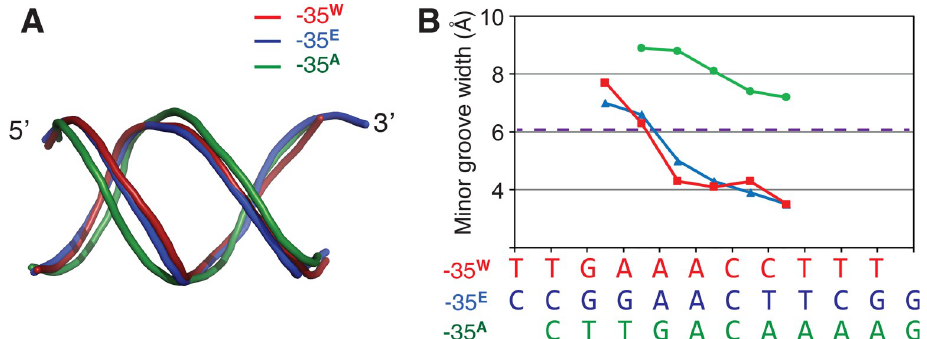
Fig 3. DNA conformation of the -35 promoter element. (A) DNA backbone geometry. -35 elements from the structures of σ W 4 /-35 W , E . coli σ E 4 /-35 E (PDB ID: 2H27), and Thermus aquaticus σ A 4 /-35 A (PDB ID: 1KU7) are superposed. The 5 0 and 3 0 -ends of the non-template strands are labeled. -35 W , 35 E , and -35 A are colored red, blue, and green, respectively. (B) Plot showing the minor groove width of the -35 elements. The sequences of the -35 elements are aligned with the plot. -35 W and -35 E have narrower minor grooves than a normal B-DNA, while -35 A contains a wider minor groove. The dashed purple line indicates the minor groove width of standard B-form DNA.